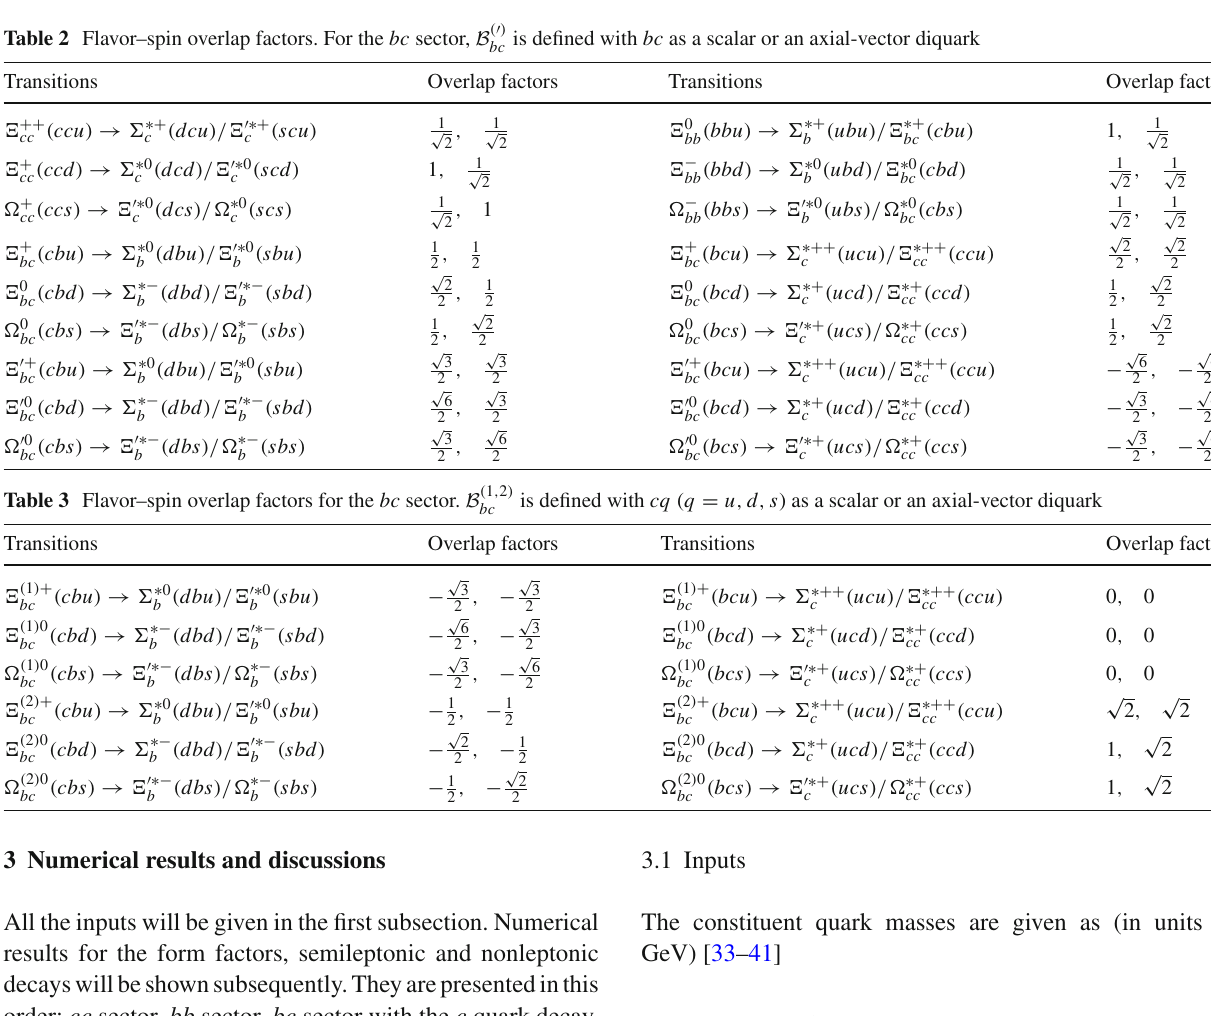
Table 2 Flavor–spin overlap factors. For the bc sector, B ( (cid:3) )